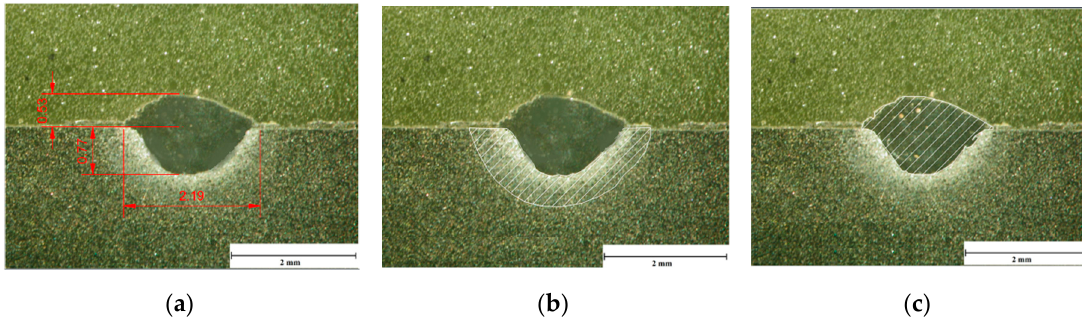
Figure 4. An example of the measuring procedure for determining the characteristic geometry features and dimensions of the stringer beads (Table 4): ( a ) measuring of the bead dimensions; ( b ) determination of the heat-affected zone (HAZ) area; ( c ) determination of the total area of the clad layer (fusion zone + clad layer).